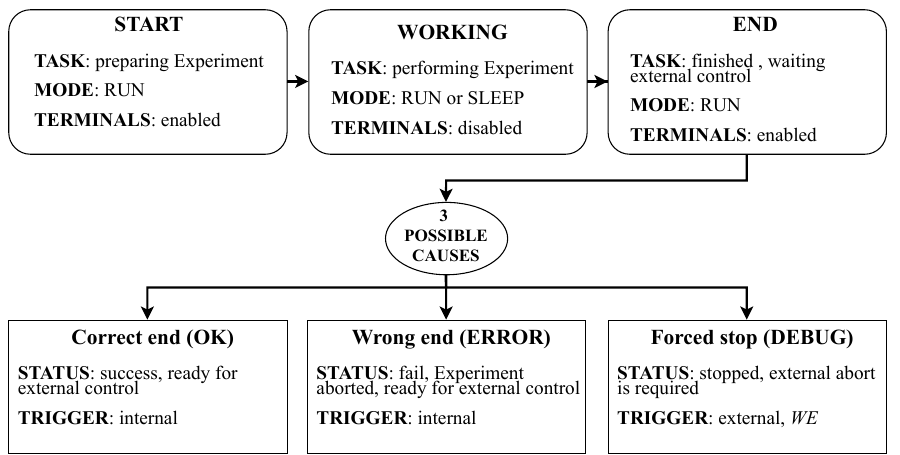
Figure 4. Detail of the experiment phases, sensor node status, and operation modes triggering